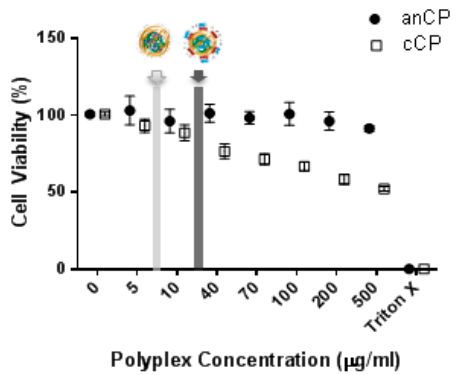
Figure 3. Cell viability assayed by MTT after 4 h incubation (mean ± SD, n = 9 from three independent